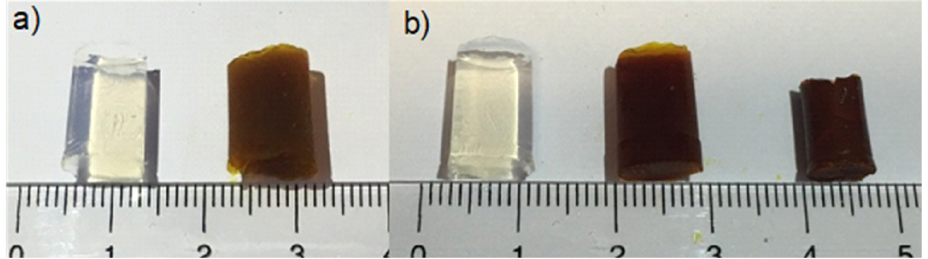
Figure 9. Images of Silica aerogels: ( a ) SIL1: Blank and Zn(II)-AHBD impregnated, respectively; ( b ) SIL2: Blank, Zn(II)-AHBD impregnated and Zn(II)-AHBD + [Aliquat][Cl] impregnated, respec- tively.